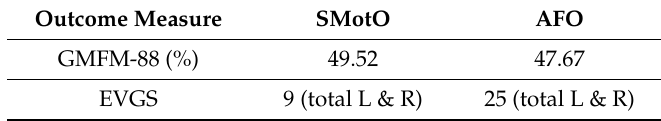
Figure 8. Participant 7 left and right initial pedograph footprint (2016). Figure 9. Participant 7 left and right final pedograph footprint (2017). Correlating videos (in DropBox folder link below) highlighting the participant’s gait in SMotO and barefoot (as labelled) for ‘Participant 7’ have been provided for reference. Participant 7 did not complete any other outcome measures. https://www.dropbox.com/sh/i25vyb9jnd5v6f2/AABj5pBSJ4MNBj9kk4LPDbRSa?dl=0 Table 8. Participant 7 EVGS results SMotO and barefoot. Outcome Measure